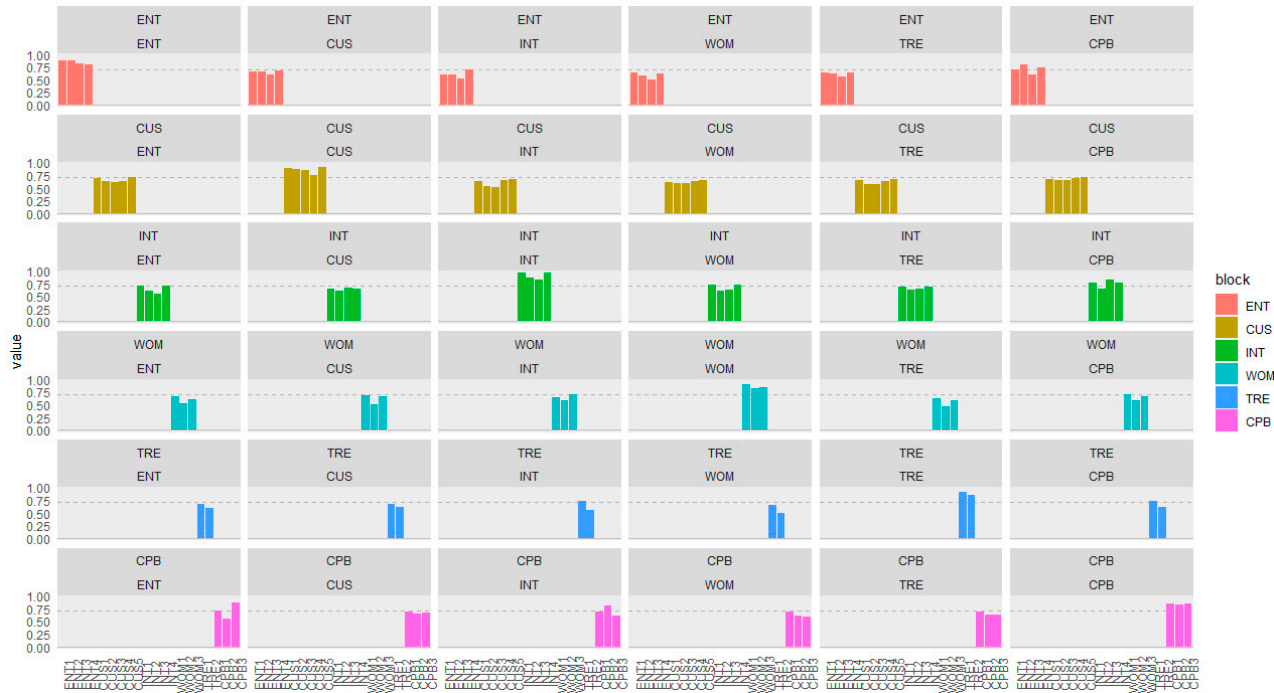
Table 3. Discriminant validity with HTMT.